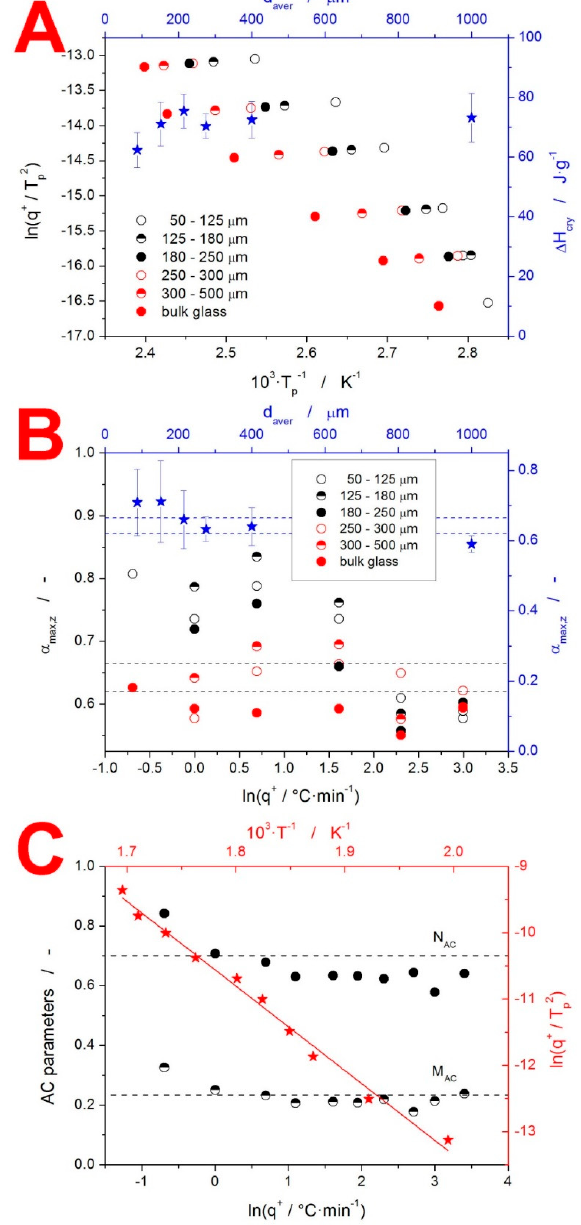
Figure 5. ( A ) Kissinger plot (constructed from the DSC crystallization measurements) for the dif- ferent powder fractions of amorphous IMC. The right and top axes and star-shaped data points show the average crystallization enthalpy for each powder fraction (bulk samples were assigned as d aver = 1000 µm). ( B ) Left and bottom axes show the q + dependence of α max,z for the crystallization measurements of the different IMC powder fractions. The right and top axes and star-shaped data points show the average α max,z values for each powder fraction. The two pairs of horizontal dashed lines indicate the region of the JMA model applicability. ( C ) Left and bottom axes show the q + de- pendence of the AC model parameters M and N, determined via sc-MKA for the decomposition of the IMC material measured by TGA. The dashed lines show the average M and N values obtained from the standard MKA. The right and top axes and star-shaped data points show the Kissinger plot constructed for the TGA decomposition data.